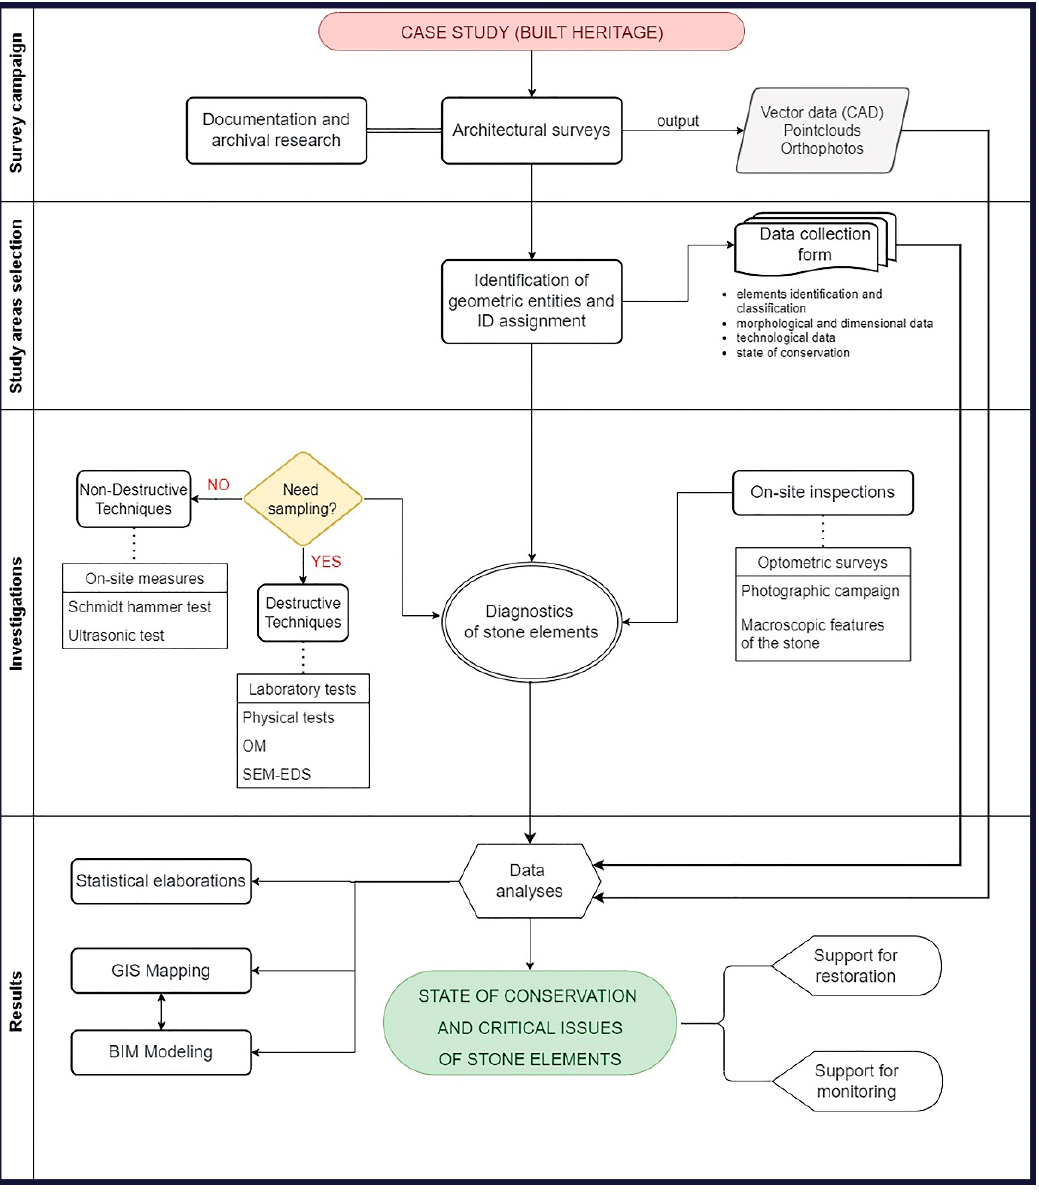
Figure 1. Representation of the diagnostic project workflow.